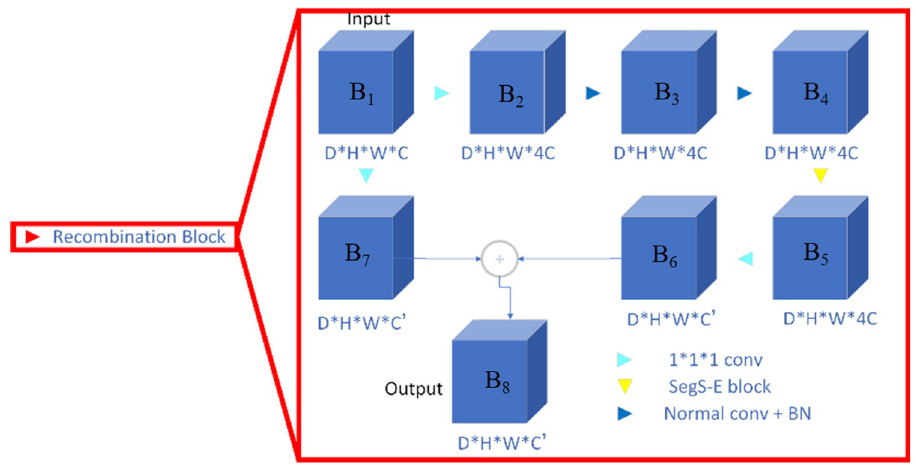
Fig 3. The recombination block. “Normal conv” refers to 3 × 3 × 3 convolution filters and batch normalization; “1 × 1 × 1 conv” refers to 1 × 1 × 1 convolution filters.